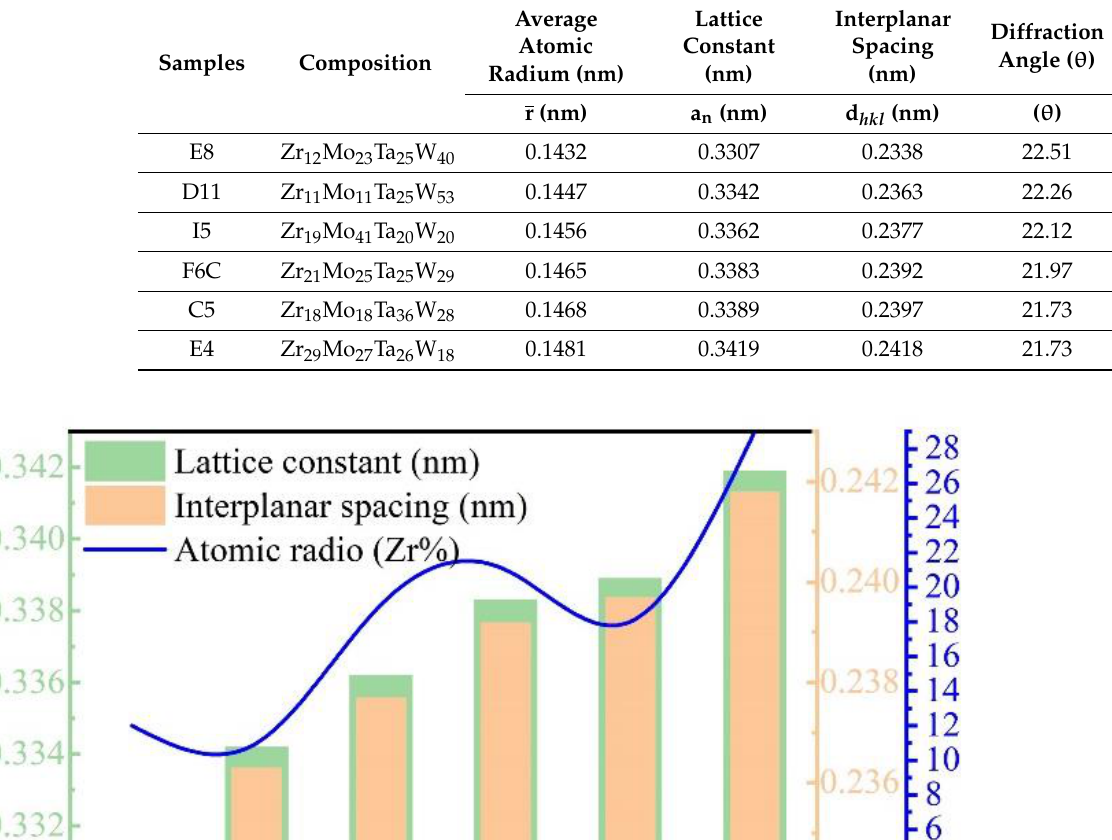
Table 5. Average atomic radium, lattice constant, interplanar spacing, and diffraction angle (110).